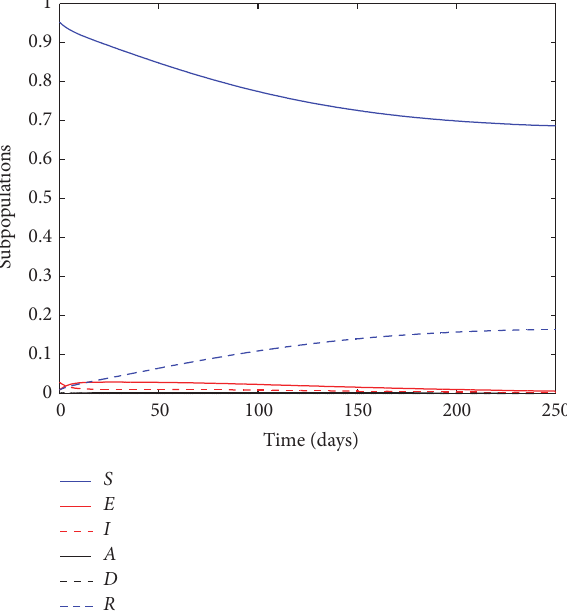
Figure 4: Evolution of the subpopulations with a daily culling rate of 𝜌 𝐷 = 0.8